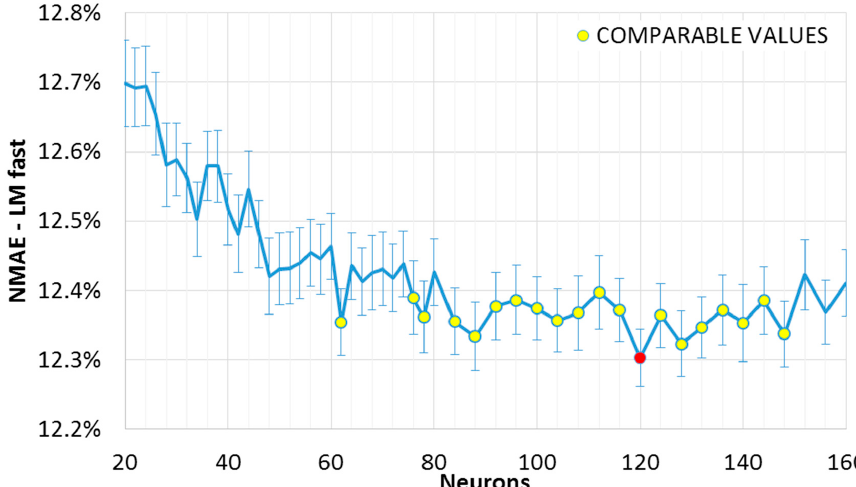
Figure 1. Mean normalized mean absolute error ( NMAE % ) as a function of the number of neurons, with Levenberg–Marquardt training algorithm set for a faster convergence. Comparable mean NMAE % in yellow, with 95% interval of confidence, with the minimum in red.